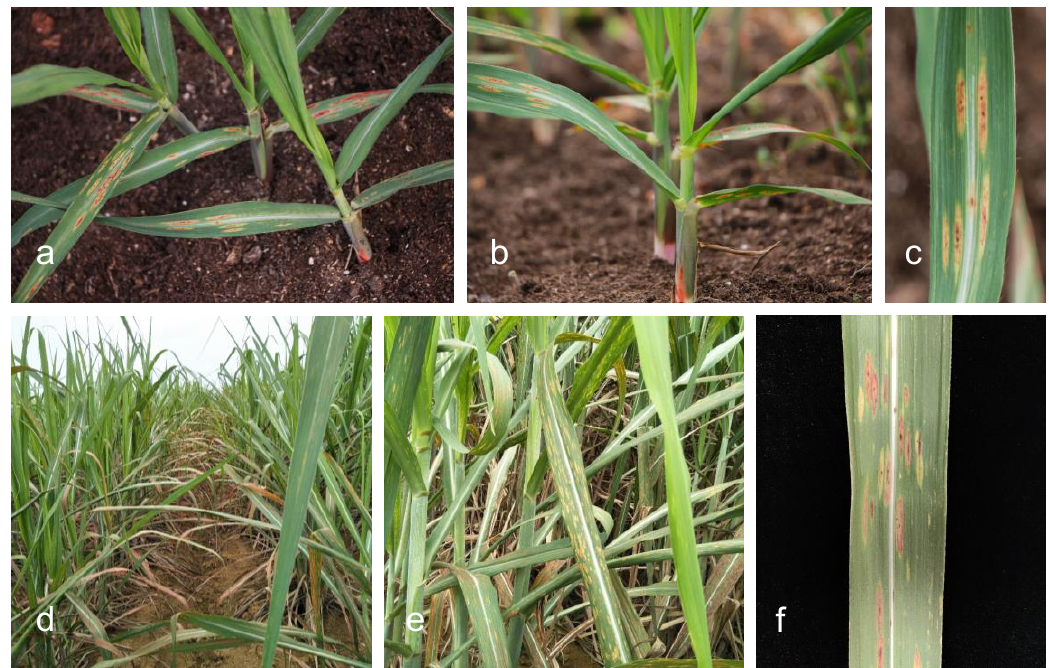
Figure 1. Symptoms of leaf blight on naturally infected sugarcane. ( a – c ). Typical symptoms of leaf blight on young sugarcane leaves in the field. ( d – f ). Typical symptoms of leaf blight on old leaves in the field.